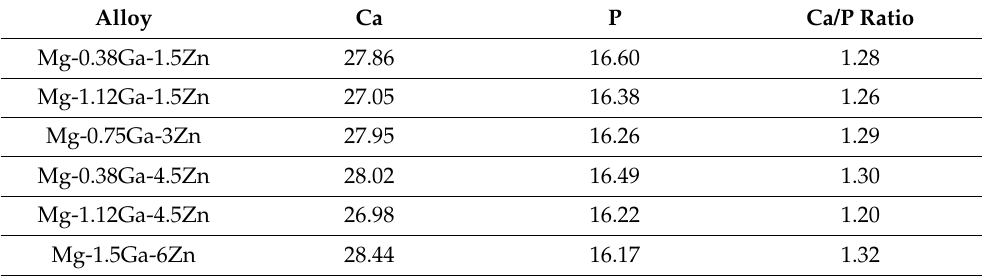
Table 3. Concentration of Ca and P (wt. %, EDS semiquantitative analysis) and Ca/P atomic ratio (Ca and P in at. %) of the compounds formed on the alloys. Alloy Ca P Ca/P Ratio Mg-0.38Ga-1.5Zn 27.86 16.60 1.28 Mg-1.12Ga-1.5Zn 27.05 16.38 1.26 Mg-0.75Ga-3Zn 27.95 16.26 1.29 Mg-0.38Ga-4.5Zn 28.02 16.49 1.30 Mg-1.12Ga-4.5Zn 26.98 16.22 1.20 Mg-1.5Ga-6Zn 28.44 16.17